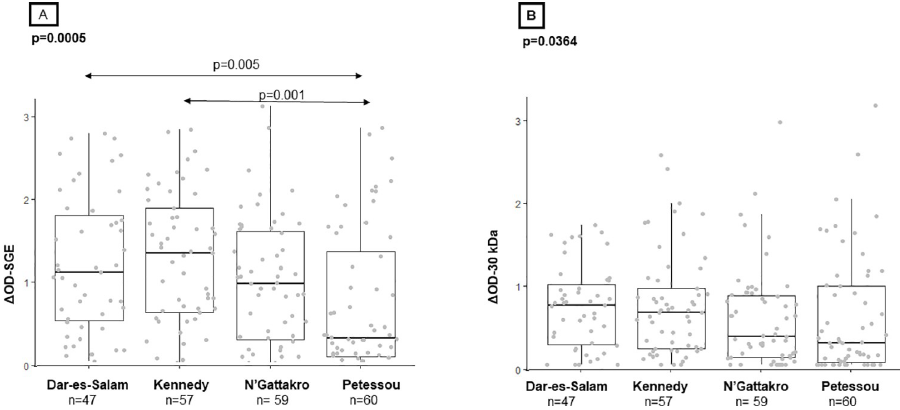
Fig 3. IgG responses to Cx . quinquefasciatus SGE and the 30 kDa recombinant protein in the four study sites. Each dot represents an individual and box plots indicate the median value, 25th and 75th percentile IgG response ( Δ OD) against SGE (A) and the 30 kDa (B). The number of processed sera is indicated below ( n ). Significant p-values are indicated above the plots.